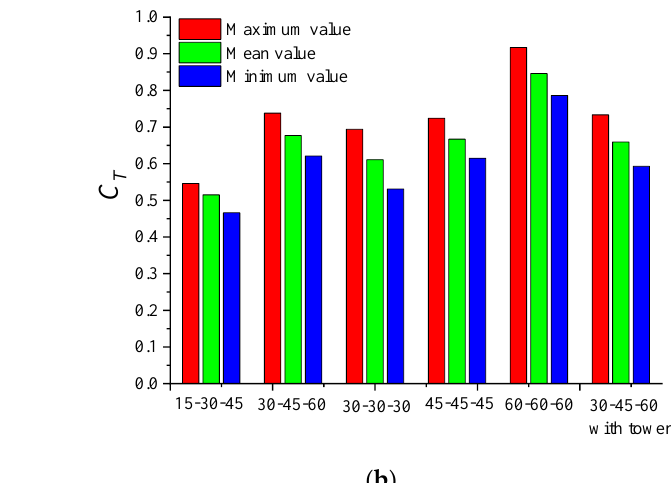
C and C for the five ASWT rotors at T S R =1.5: ( a ) Figure 13. Maximum, minimum, mean C P and C T for the five ASWT rotors at TSR = 1.5: ( a ) C P ; ( b ) C T T P